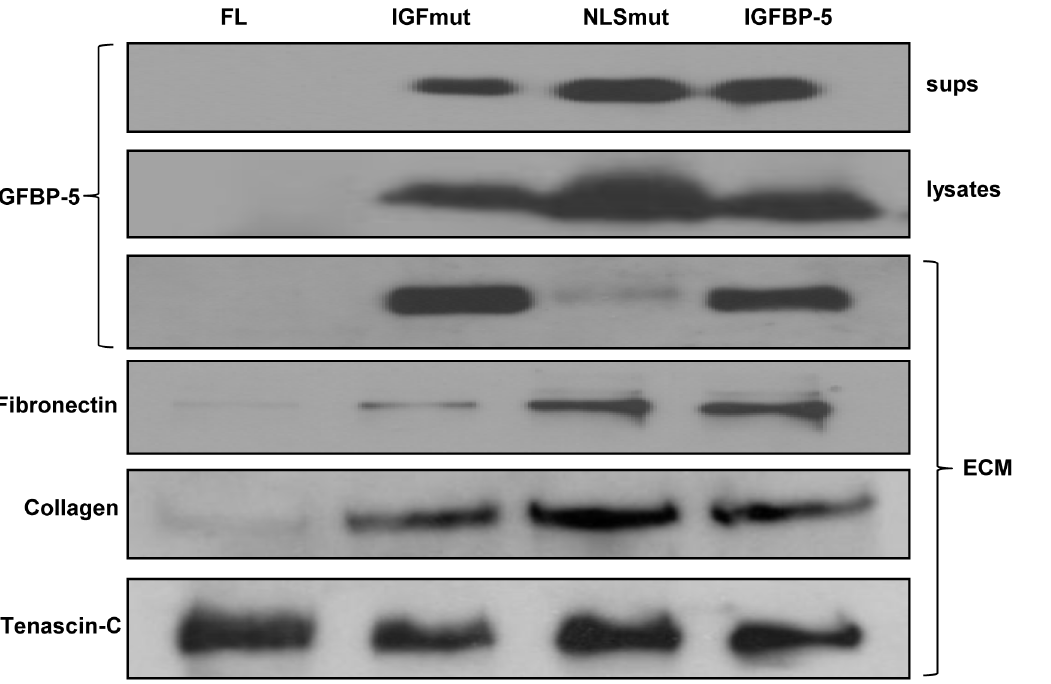
Fig 2. Mutant IGFBP-5 exerts in vitro pro-fibrotic activity that is similar to that of wild-type IGFBP-5. Primary human fibroblasts were infected with adenovirus expressing wild type IGFBP-5, IGF binding site-mutant IGFBP-5, or NLS-mutant IGFBP-5. Cell culture supernatants (sups), cellular (lysates), and extracellular (ECM) fractions were analyzed by